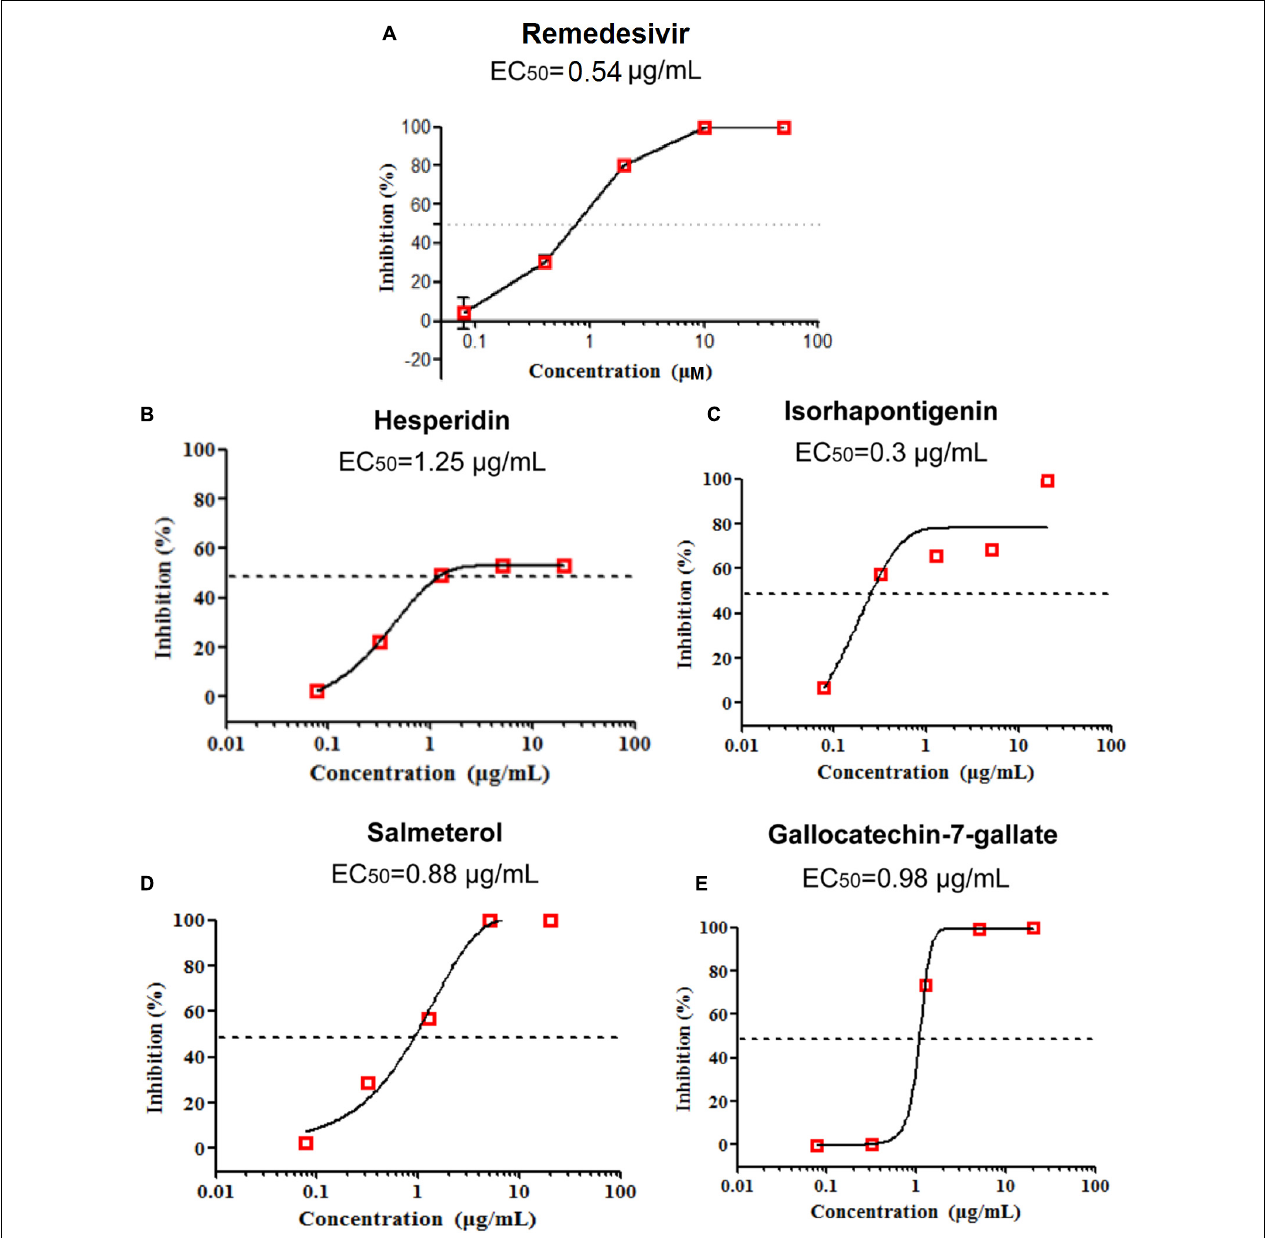
FIGURE 7 | Remdesivir was used as the positive control drug (A) . The anti-SARS-CoV-2 activity of three natural products (hesperidin, isorhapontigenin, and gallocatechin-7-gallate) and one approved drug (salmeterol) in vitro (B–E)